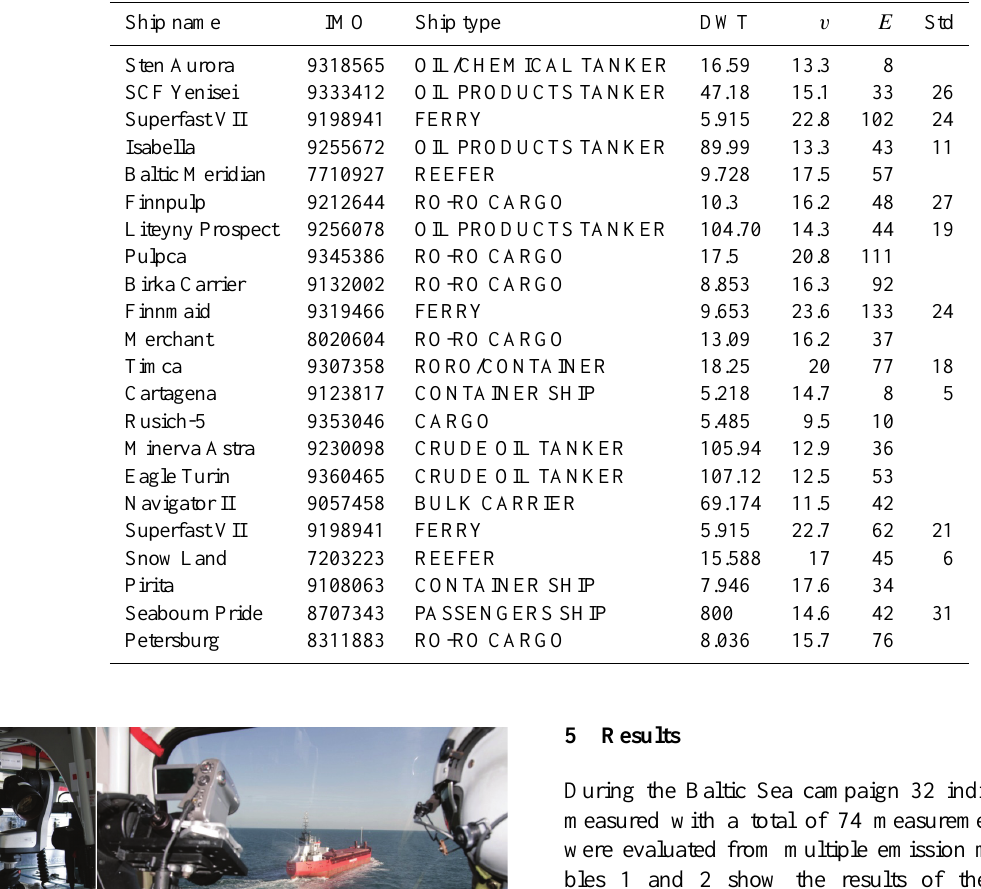
Table 1. Optical SO 2 measurements of ship emission rates performed on the Baltic sea outside Gotland on 5 days between 13 and 24 Au- gust 2008. The acronyms in the header correspond to IMO number of ship, Dead Weight Ton (DWT), ship speed in knots ( v ), mean SO 2 emission ( E ) in kgh − 1 , and 1- σ emission variability (STD) in %.